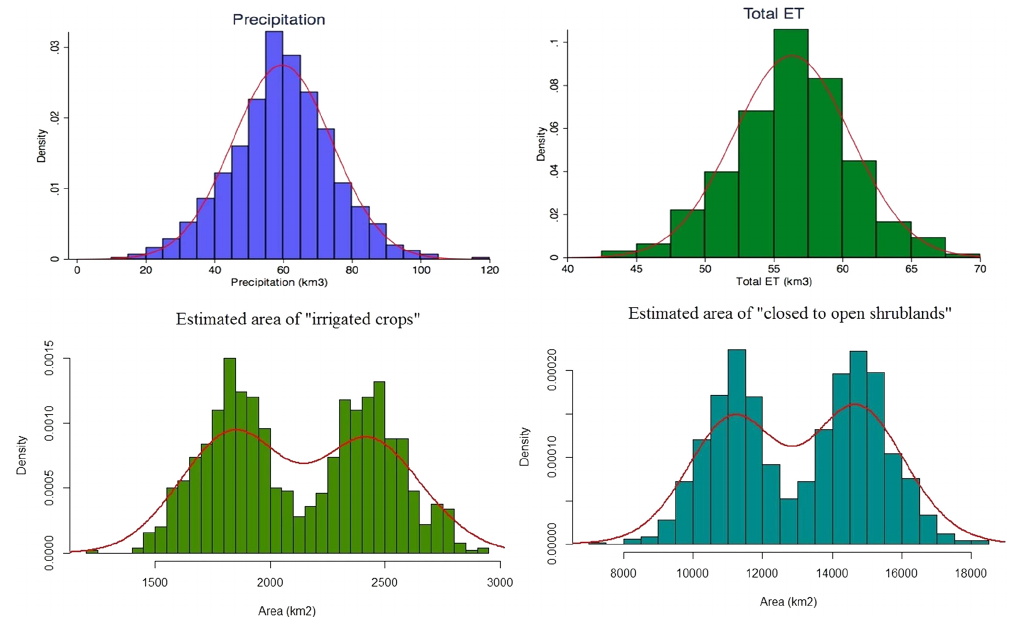
Figure 8. Example of the frequency distribution of the randomly simulated input parameters ET, rainfall and land use into the Monte Carlo simulations for 2009 (for land use estimated area of two classes, i.e., irrigated crops and closed to open shrublands, are demonstrated).